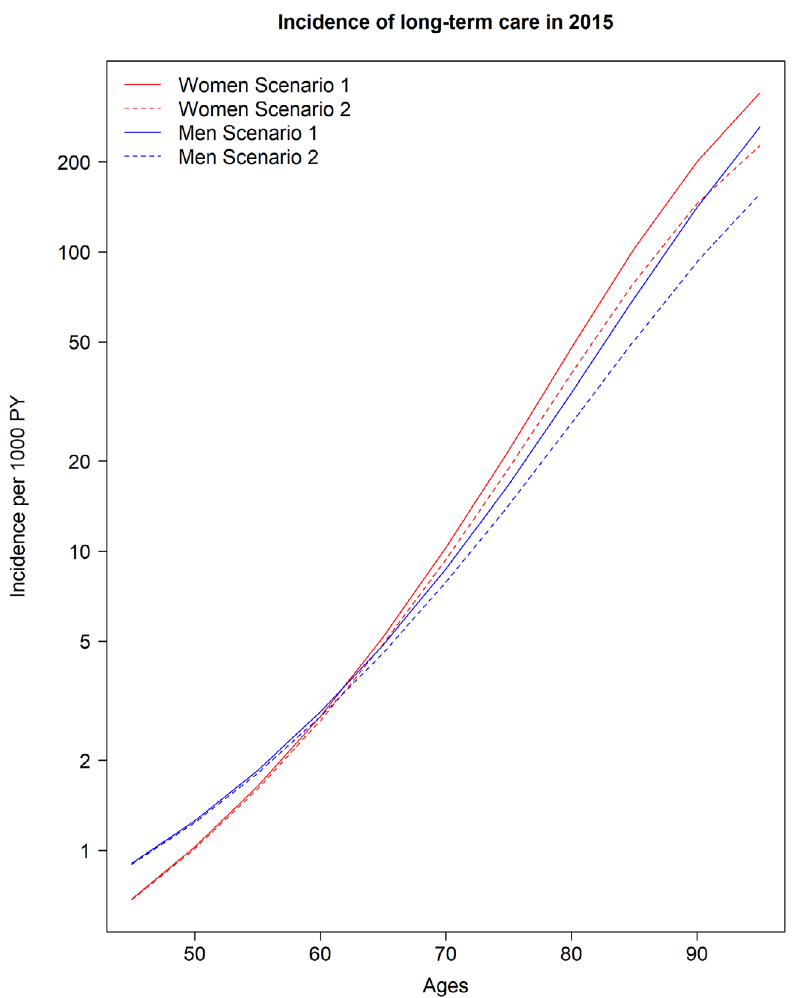
Figure 2. Logarithmic age-specific incidence rates per 1000 person-years in two scenarios depending on age, sex and mortality rate ratios ( R ) for the year 2015. Scenario 1: R = 3.2; Scenario 2: R =